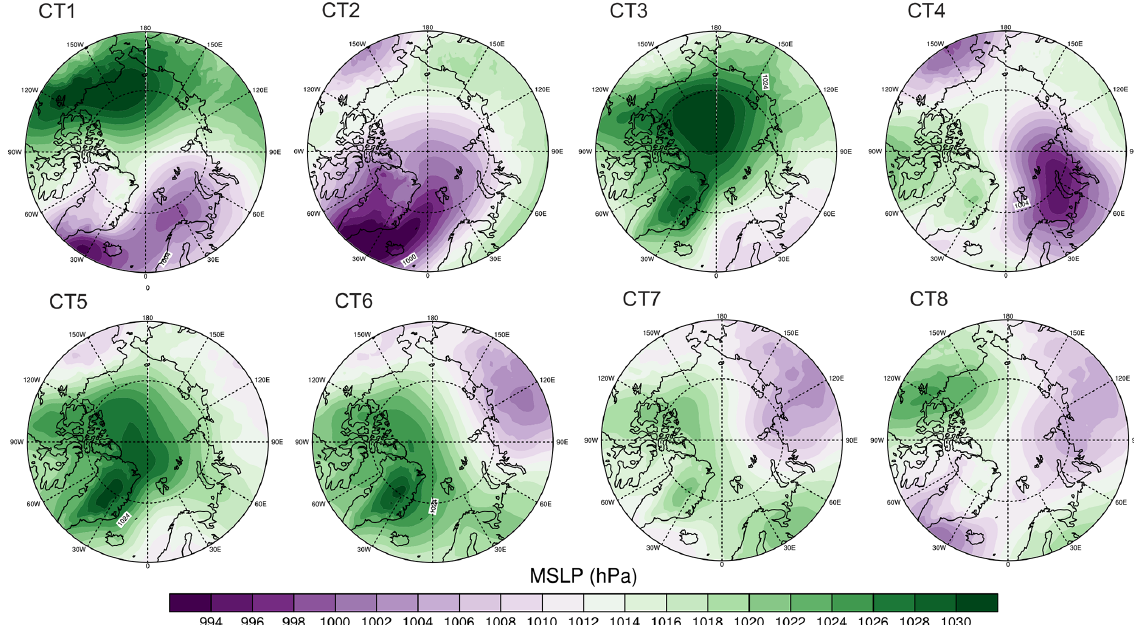
Figure 2. Mean sea level pressure (MSLP) averaged over the cases belonging to each of the eight circulation types chosen from the 20 circulation types shown in the Appendix A.